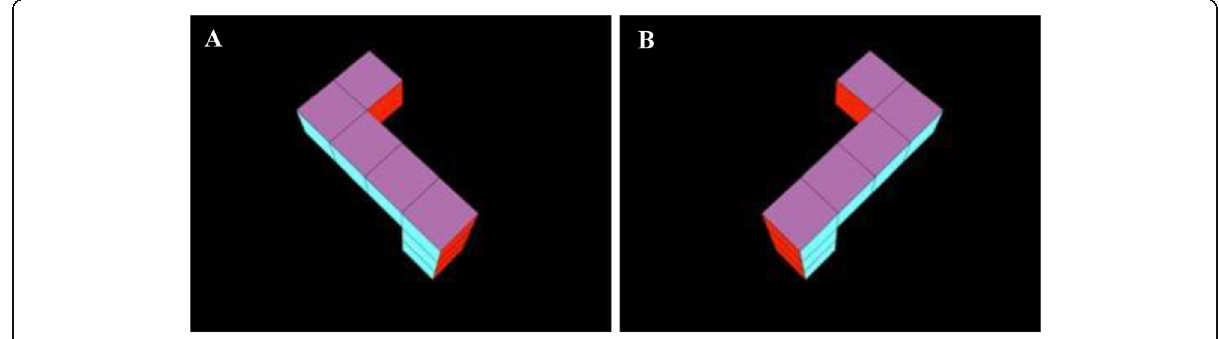
Fig. 2 Test stimulus objects used by Christodoulou et al. (2016), Constantinescu et al. (2018), Heil et al. (2018), Moore and Johnson (2008, 2011) and Slone et al. (2018). Habituated infants saw either the object in panel a or the object in panel b rotating back and forth on its vertical axis through a never-before-seen 120 degrees of arc. Panel a represents the “ back side ” of the habituation object seen in Fig. 1. Panel b represents the mirror-image of the object seen in panel a . Moore and Johnson (2008, 2011) presented the objects seen in panels a and b in alternation in a series of 6 test trials. Adapted from Constantinescu et al. (2018), Fig.